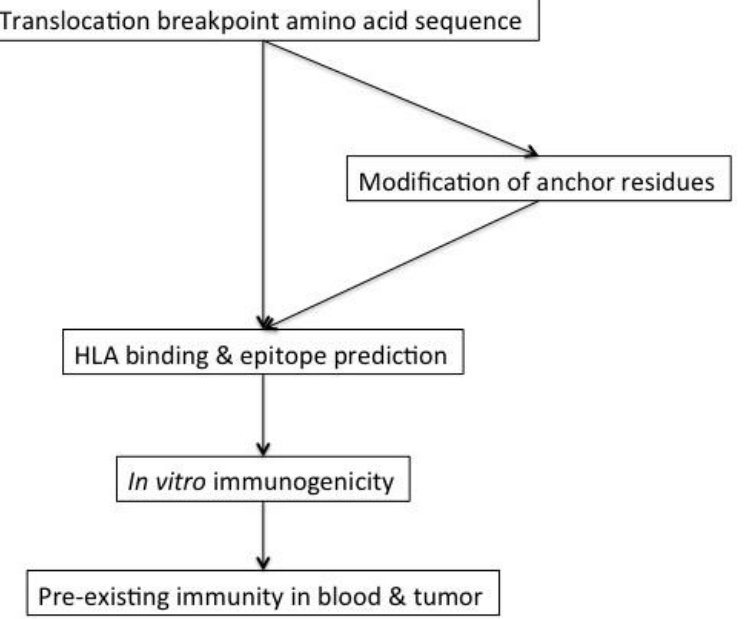
Figure 1. Schematic representation of immunogenicity testing of the translocation breakpoints in